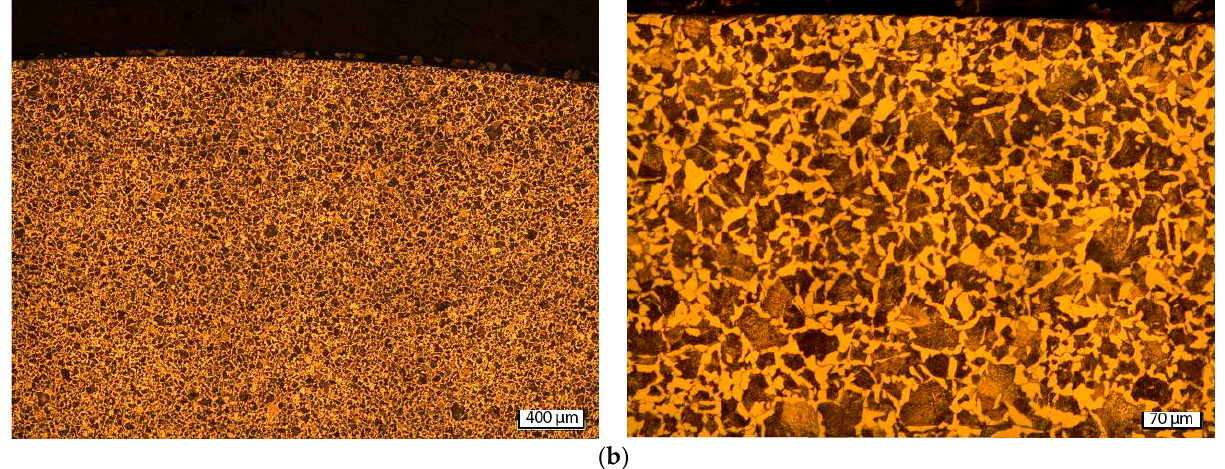
Figure 9. Microstructure of burnished samples No. 6, burnishing with lubricant/MQL ( a ) and No. 50 ( b ), dry burnishing.